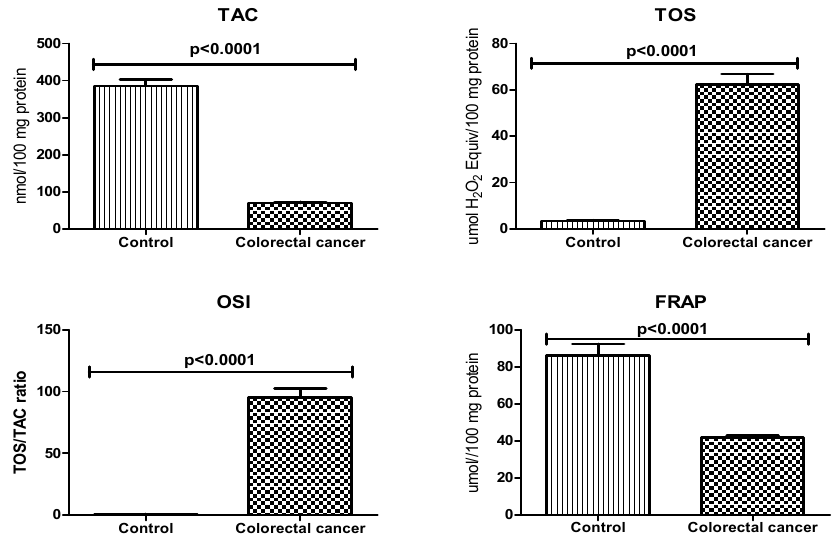
Figure 3. Total antioxidant / oxidant status in patients with colorectal cancer and the control group. Abbreviations: TAC, total antioxidant capacity; TOS, total oxidant status; OSI, oxidative stress index; FRAP, ferric reducing ability of sample.